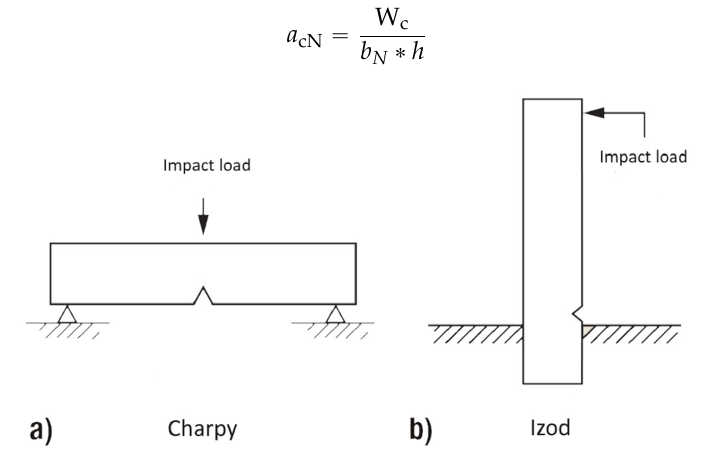
Figure 7. Impact loading in ( a ) Charpy and ( b ) Izod configuration.